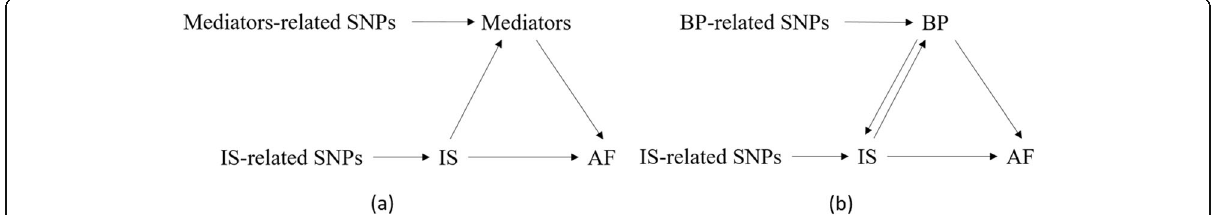
Fig. 1 a Network Mendelian randomization analysis framework; b Graphical diagram of network relationship among IS, AF and